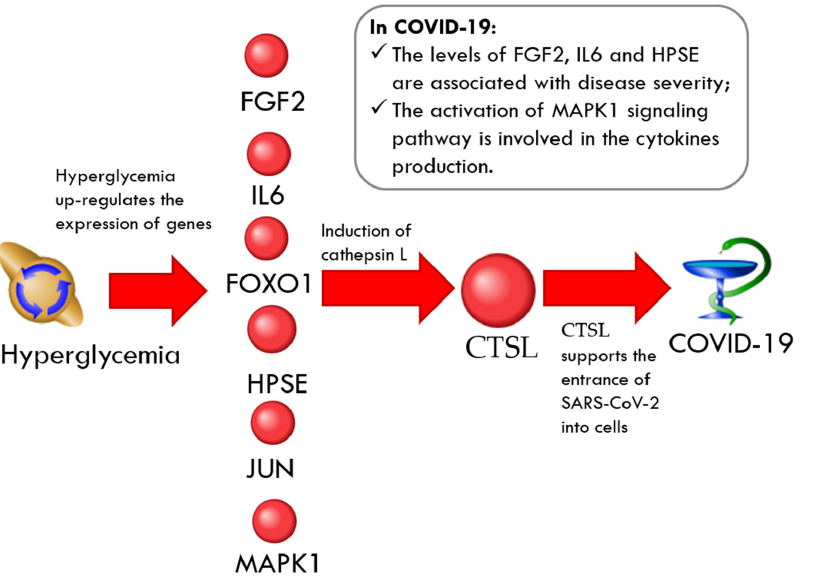
Figure 8. The regulation loop in the CTSL-related network involves FGF2, IL6, FOXO1, HPSE, JUN, and MAPK1. and